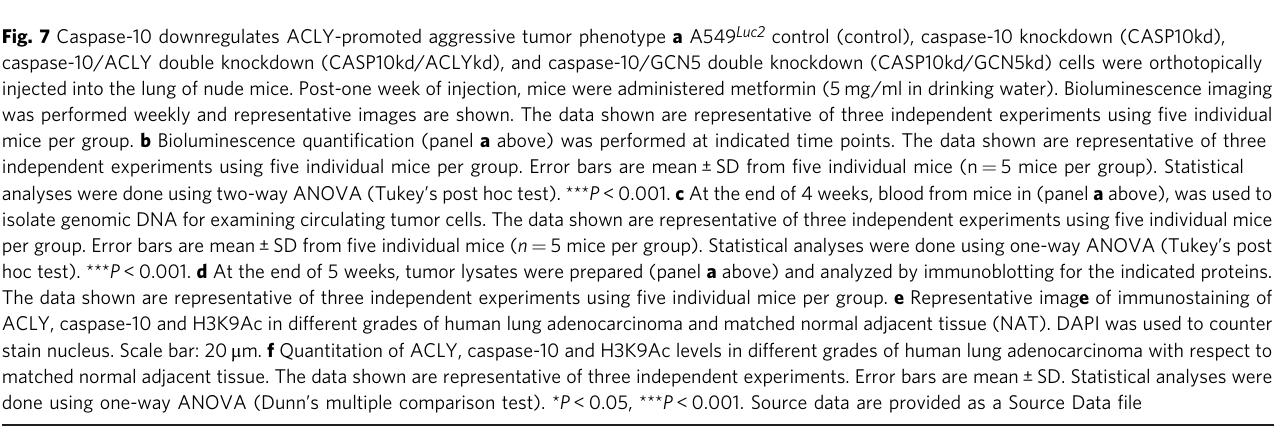
Fig. 7 Caspase-10 downregulates ACLY-promoted aggressive tumor phenotype a A549 Luc2 control (control), caspase-10 knockdown (CASP10kd), caspase-10/ACLY double knockdown (CASP10kd/ACLYkd), and caspase-10/GCN5 double knockdown (CASP10kd/GCN5kd) cells were orthotopically injected into the lung of nude mice. Post-one week of injection, mice were administered metformin (5 mg/ml in drinking water). Bioluminescence